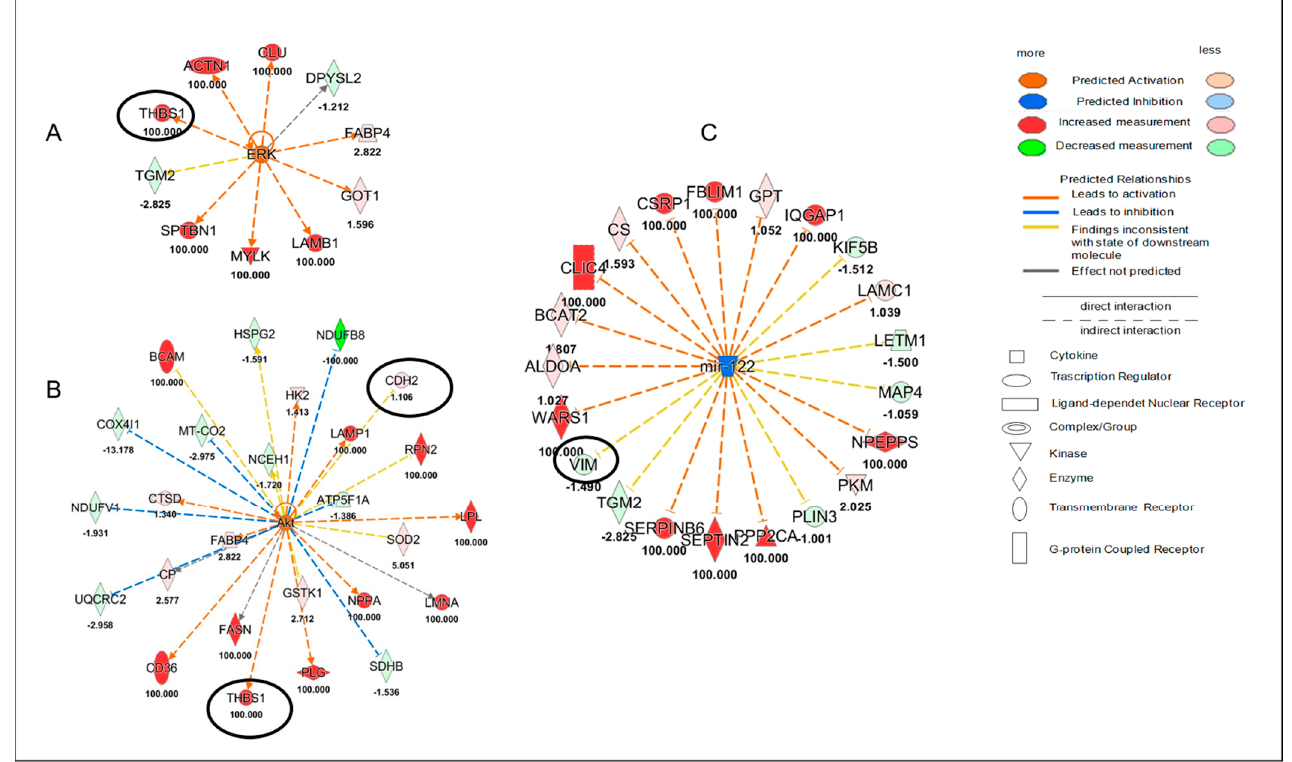
Figure 2. Female proteomic analysis. Upstream network effects of a quantified protein in the Ingenuity Pathway Analysis (IPA) revealed the activation of ERK ( A ) and Akt ( B ) as well as the inhibition of miR-122 ( C ) in female mice cardiac tissue treated with ponatinib compared to control ones. Red and green shapes represent increased or decreased measurements of quantified proteins, respectively. Color intensity is directly proportional to the fold change value of each protein reported in the figure. Circles show proteins related to Cx43. Color key and symbols are reported in the legend.